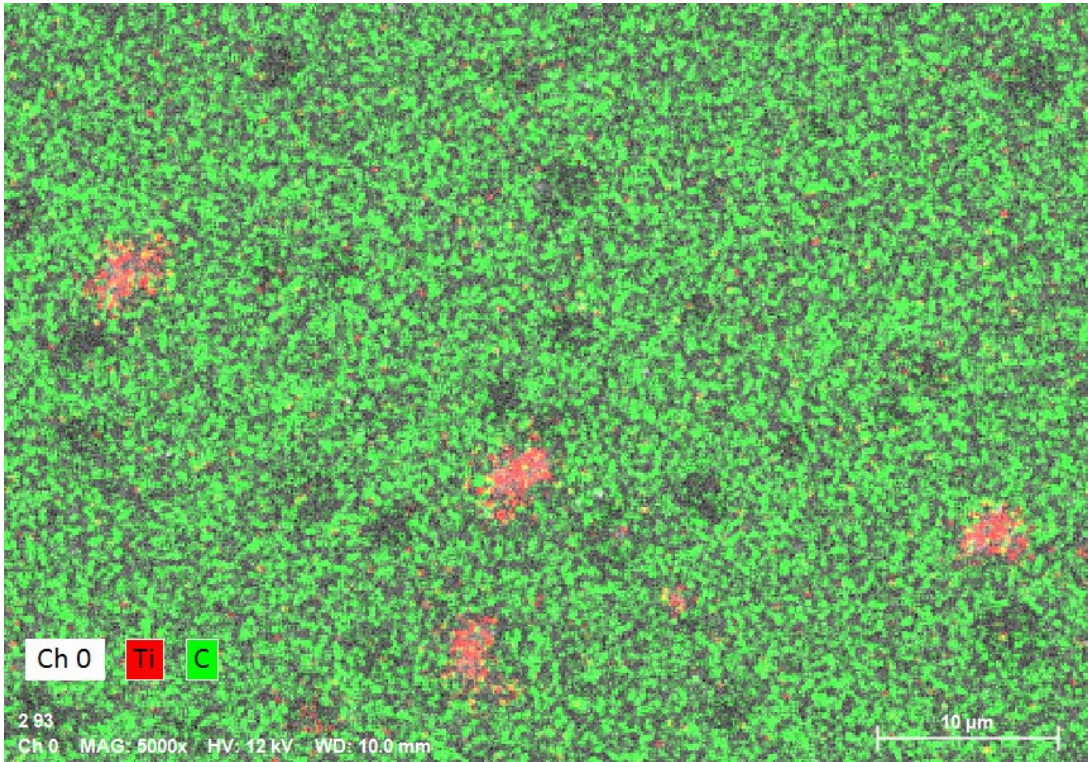
Figure 4. Element map of the nanocomposite for Ti (TiO 2 NPs Cp = 1 wt%) using energy-dispersive X-ray spectroscopy (EDS) on SEM (nanocomposite manufactured without the sonication process).